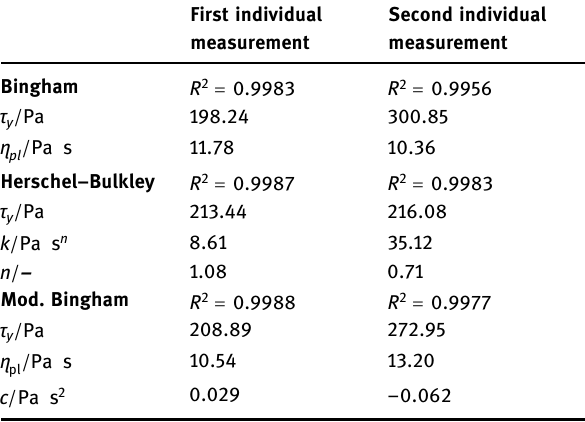
Table 3: Model parameters of the Bingham, Herschel – Bulkley, and modi fi ed Bingham models for the fi ts of the mean values of the fi rst two individual measurements